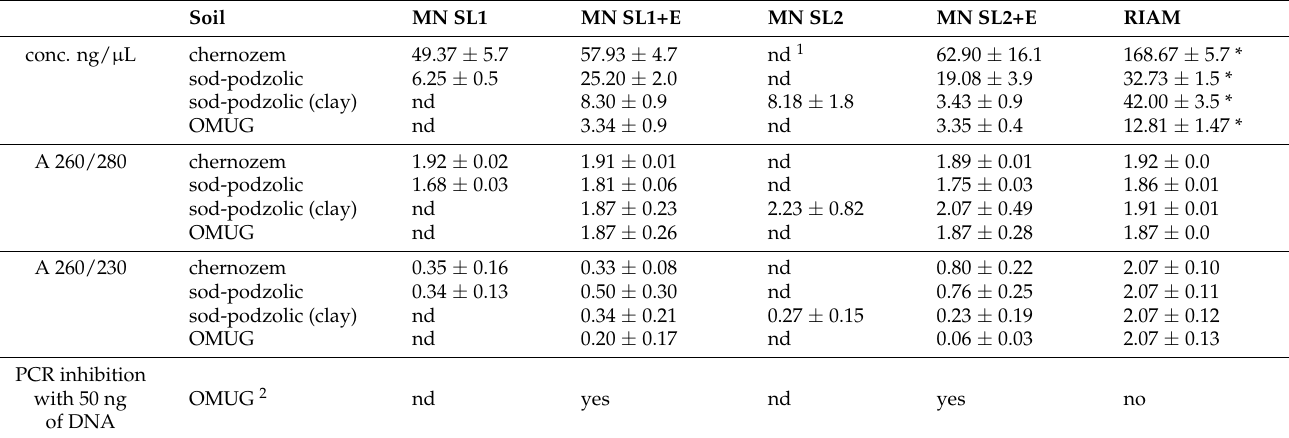
Table 1. The concentration of isolated DNAs and purity